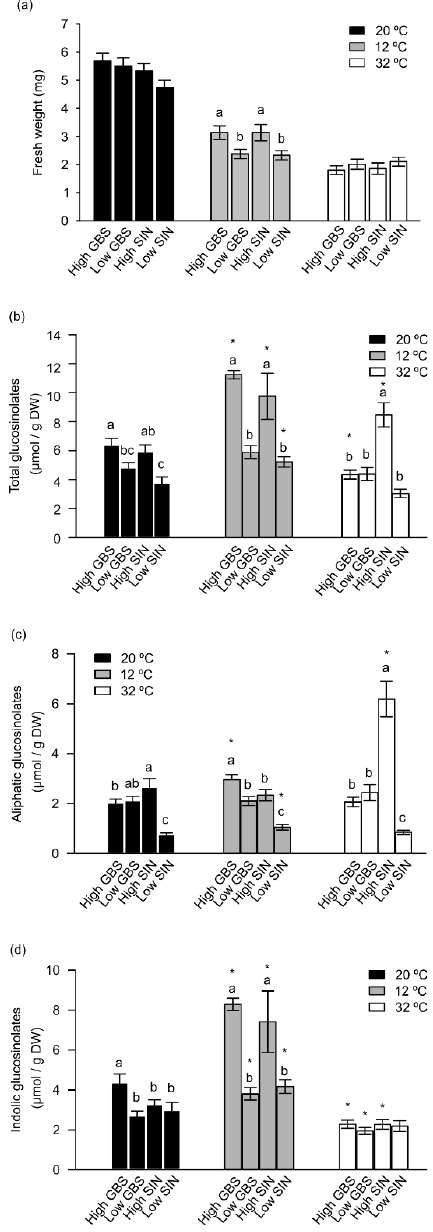
Figure 1. Effect of air temperatures on fresh weight and glucosinolates content on four kale populations from two divergent selections. ( a ) Bars represent the mean of the weight of 25 biological replicates per genotype and temperatures. Error bars represent ± SE. Different letters above the bar within each temperature [control (20), 12 and 32 °C] indicate significant differences ( p ≤ 0.05, ONE-way ANOVA). ( b – d ) Glucosinolates content in four populations from two divergent selections for sinigrin (SIN) and glucobrassicin (GBS) content. Bars represent the mean content of 10 biological replicates per genotype and temperature. Error bars represent ± SE. Means with a * indicate significant differences between temperature treatment and control within each population ( p ≤ 0.05, T-test). Different letters above the bar within each temperature indicate significant differences among populations ( p ≤ 0.05, one-way ANOVA).